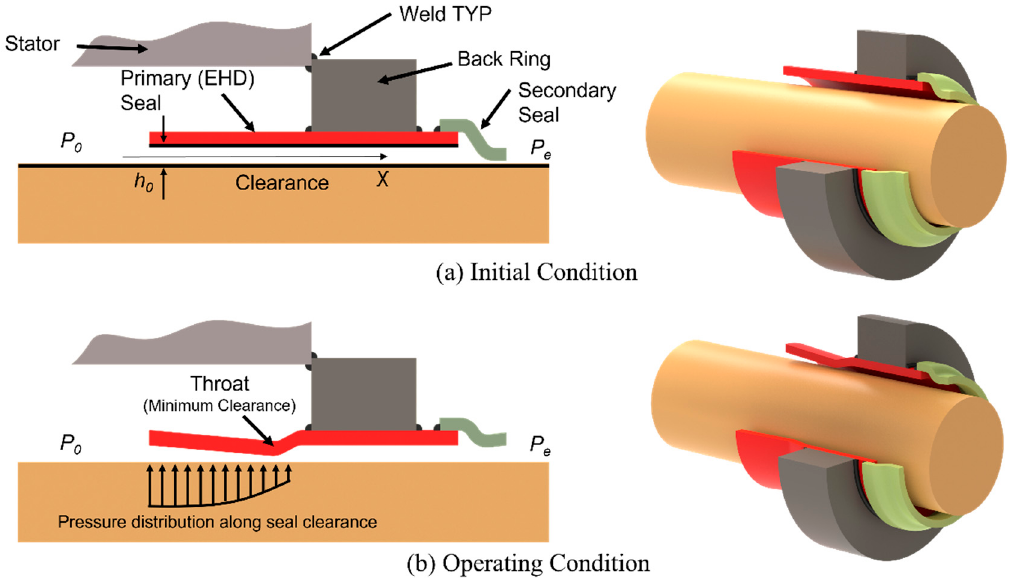
Figure 1. Working mechanism of the proposed seal concept: ( a ) initial condition and ( b ) operating condition.